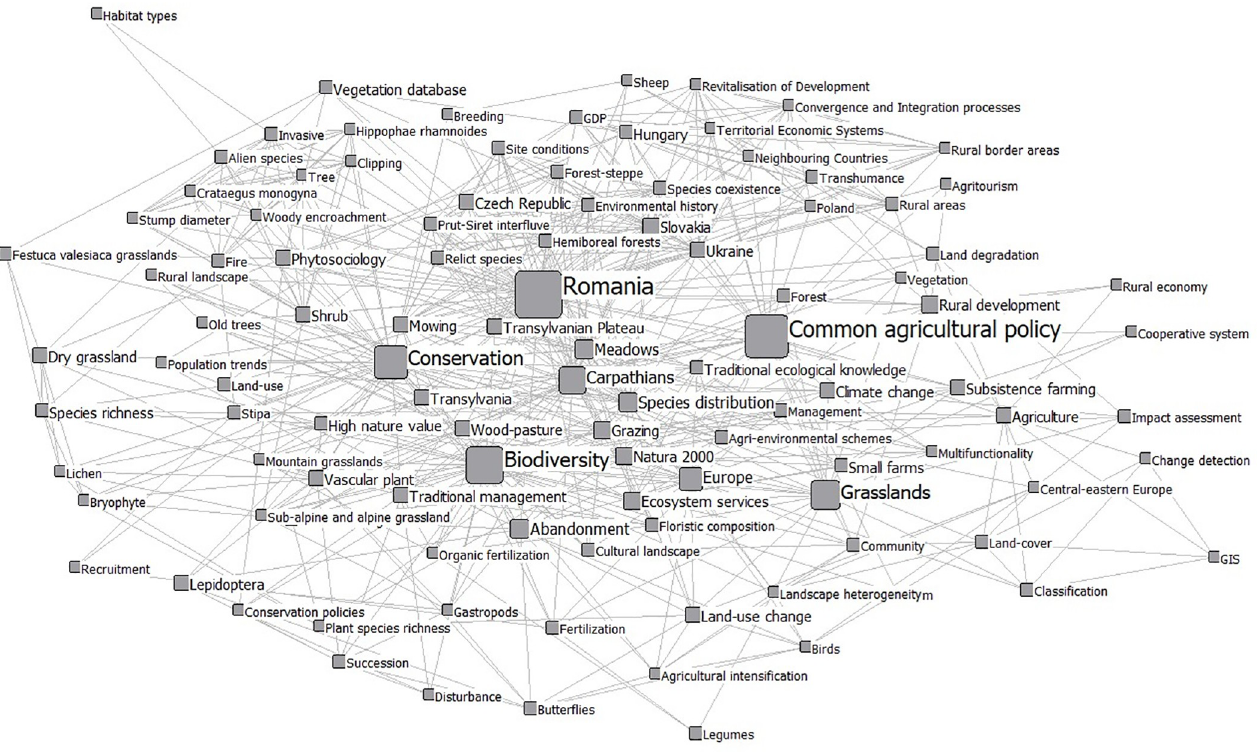
Fig 8. Top keywords used in publications about Romania’s grasslands by degree. Size of labels and nodes by degree; for a better visual representation, we include only keywords with a degree > 10.